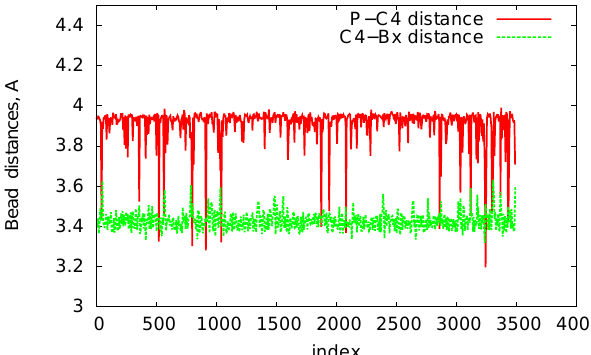
Figure 8. P-C4 and C4-Bx bond length in the three-bead Coarse-Grained (CG) model for the two-ring RNA nanotube.